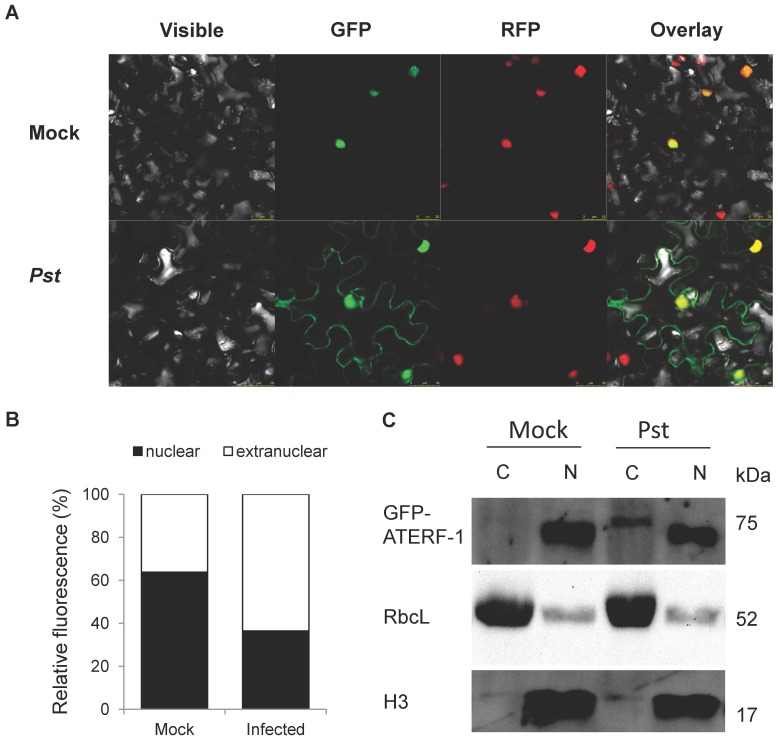
Comparison between nuclear and extra-nuclear GFP-ATERF-1 in non-infected and Pst infected plants.(A) Higher magnification photographs (25 µm scale) show extra-nuclear location of GFP-ATERF-1 in Pst-infected tobacco plants. (B) Quantification of nuclear and extra-nuclear GFP fluorescence from a total of 203 cells, in non-infected and infected tobacco plants. (C) Western-blot detection of GFP protein in cytoplasmic and nuclear fractions from 35S:GFP-ATERF-1 transgenic plants of A. thaliana. Plants were expossed to mock or Pst infection and their protein extracts were separated in nuclear (N) and cytoplasmic (C) fractions. The fractions were resolved in SDS-PAGE gels, blotted and probed against anti GFP antibodies to detect the 75 KDa, GFP-ATERF-1 fusion protein. Membranes were re-probed with anti-H3 histone (H3, nuclear) and anti RuBisCo (RbcL, cytoplasmic) antibodies.